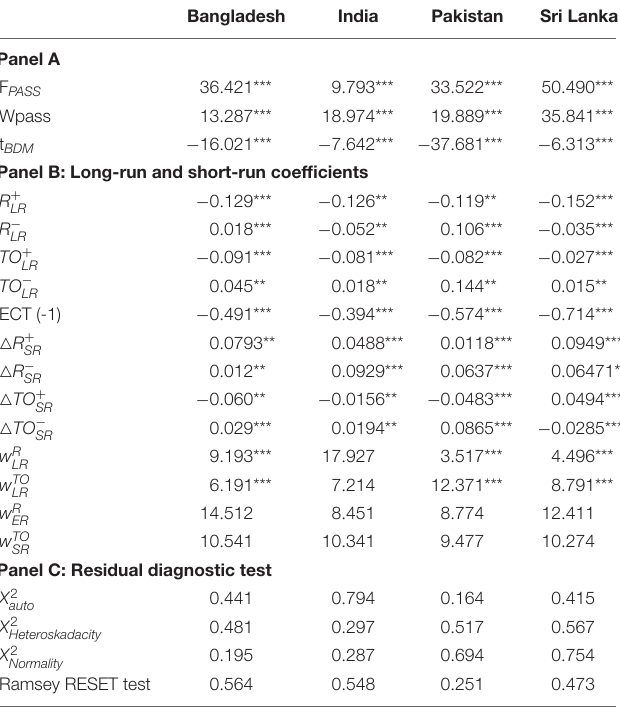
TABLE 7 | NARDL cointegration test, long-term, and short-term